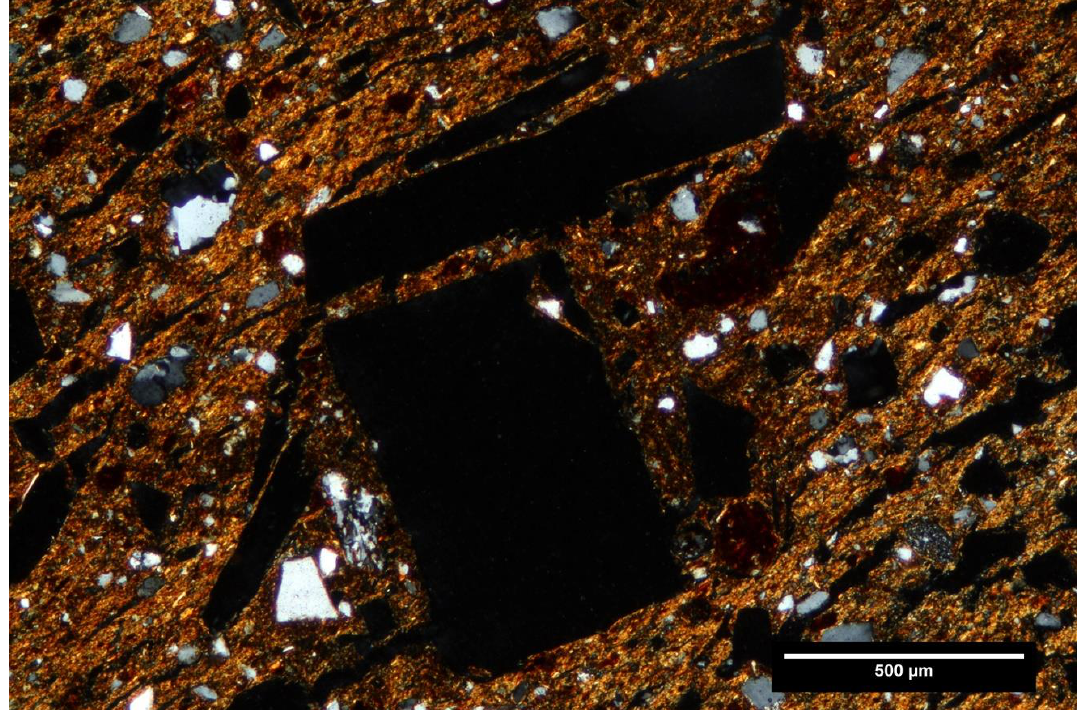
Figure 6. Large geometric voids left by the eroded calcite grains in sample MOX-32 from fabric C-1, also called calcite ghost voids. Note the similar groundmass and microstructure to Figure 4. Photomicrograph taken under crossed-polars by Jennifer Meanwell.